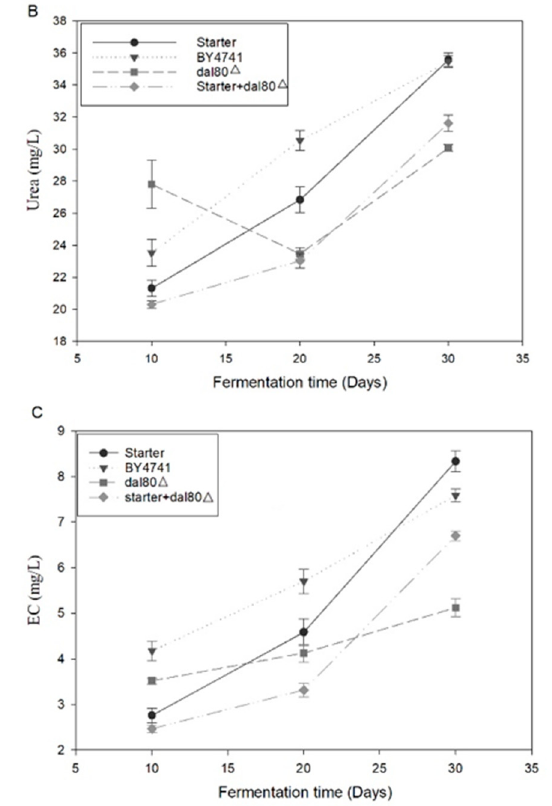
Figure 4. Effect of DAL80 deletion on EC formation during the process of Chinese rice wine fermentation. ( A ) Comparison of arginine during the process of fermentation with starter, BY4741, dal80 Δ , and a mixture of fermentation starter (50%) and dal80 Δ (50%). ( B ) Comparison of urea during the process of fermentation with starter, BY4741, dal80 Δ , and a mixture of starter (50%) and dal80 Δ (50%). ( C ) Comparison of EC during the process of fermentation with fermentation strains, such as BY4741, DAL80-deleted yeast (dal80 Δ ), and a mixture of fermentation starter (50%) and dal80 Δ (50%).